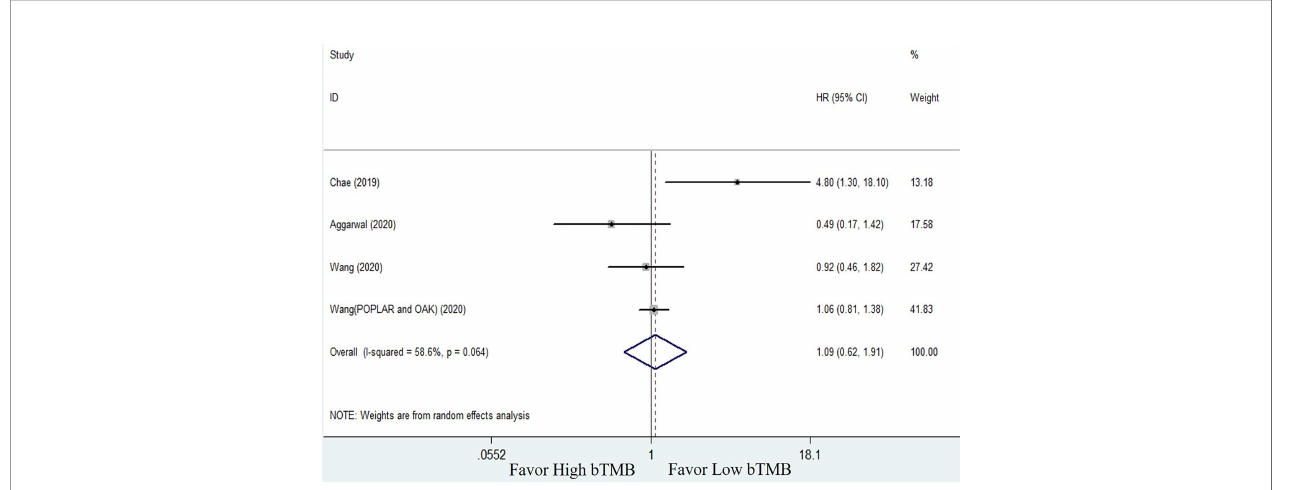
FIGURE 2 | Forest plot of clinical bene fi ts ’ comparison for overall survival (OS) between high bTMB group and low bTMB